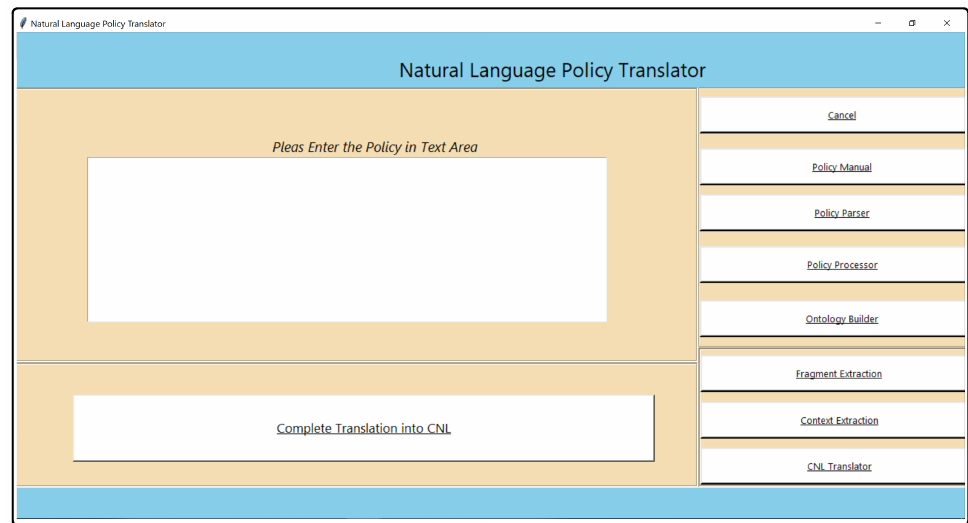
Figure 8. NLPT 2.0 graphical user